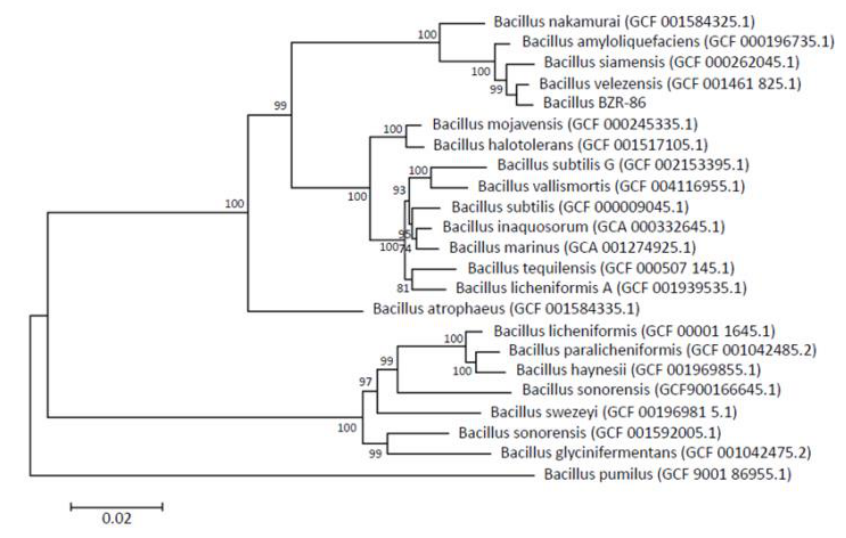
Figure 1. Maximum likelihood phylogenetic tree constructed using amino acid sequences of 120 conserved marker genes. The tree was constructed using PhyML v.3.3.